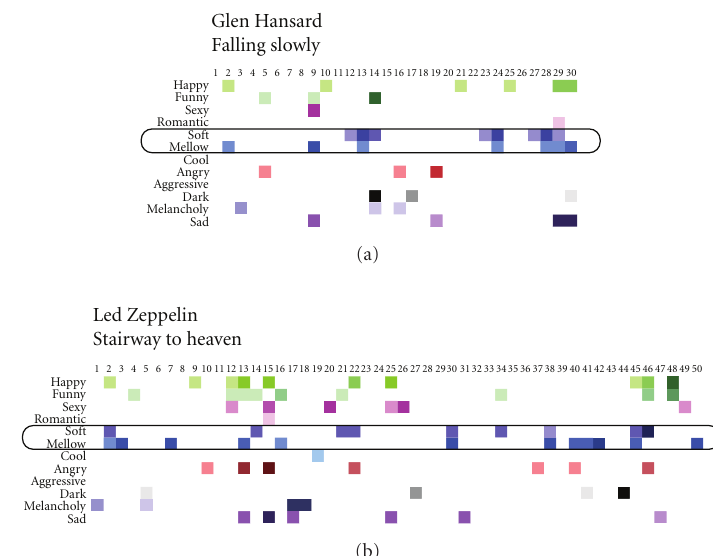
Figure 8: Pairwise comparison of patterns reflecting LSA correlation values in the lyrics of the songs (a) “Falling slowly”, and (b) “Stairway to heaven” against 12 a ff ective